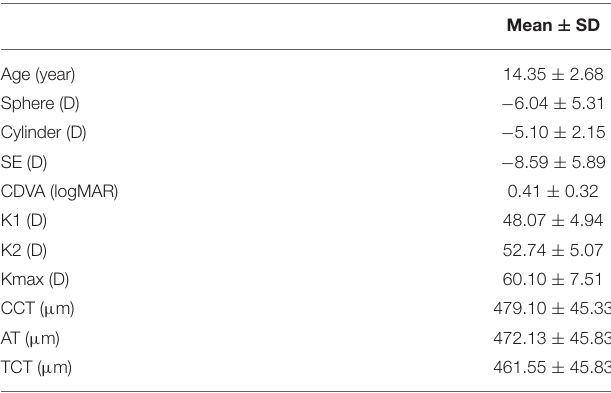
TABLE 1 | Demographic data of the patients (Mean ±